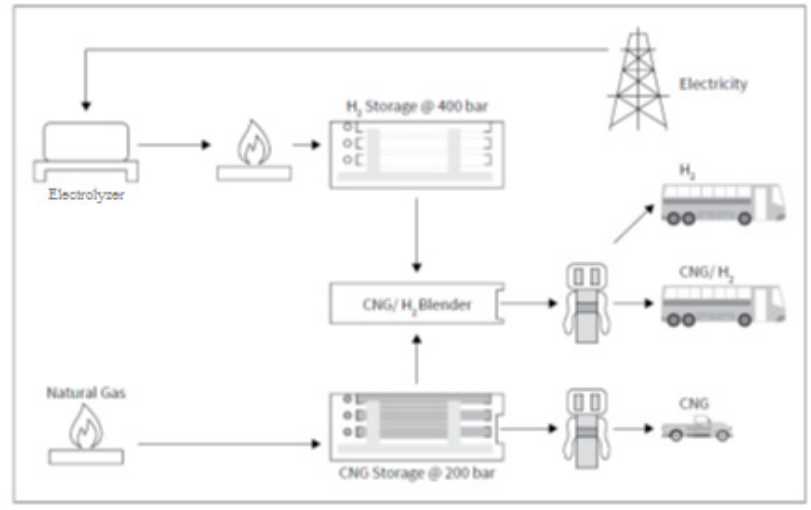
Figure 14. Scheme of an integrated filling station for compressed natural gas and methane–hydrogen mixtures (Reprinted from ref. [32]).